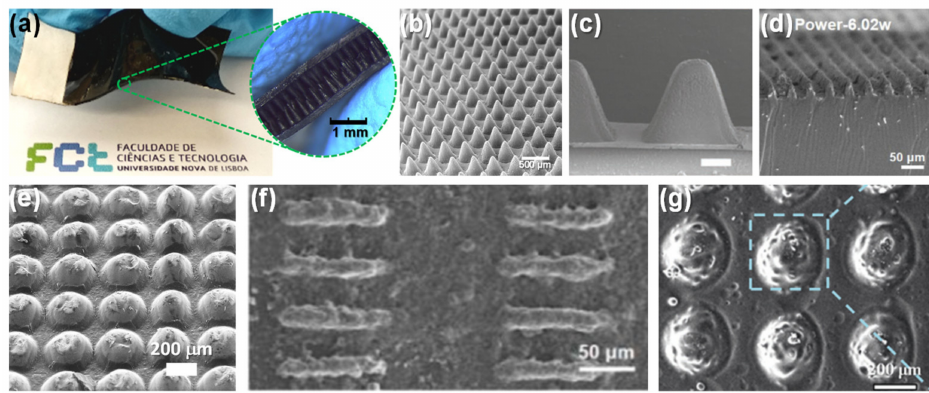
Figure 10. E-skins produced through laser engraving technique. ( a ) E-skin developed by Rui Igreja and co-workers in 2018 [22] (Copyright © 2020 WILEY-VCH Verlag GmbH & Co. KGaA, Weinheim, Germany). ( b ) SEM image of micro-cones of the e-skin in (a) [22] (Copyright © 2020 WILEY-VCH Verlag GmbH & Co. KGaA, Weinheim, Germany). ( c ) SEM image of triangular microprisms produced by Zhong Lin Wang and co-workers in 2018 (scale bar = 0.5 mm) [40] (Copyright © 2020 WILEY-VCH Verlag GmbH & Co. KGaA, Weinheim, Germany). ( d ) SEM image of triangular lines produced by Fuzhen Xuan and co-workers in 2018 [37] ( © 2020 Elsevier B.V. All rights reserved). ( e ) SEM image of semi-spheres produced by Rui Igreja and co-workers in 2019 [247]. ( f ) SEM image of short micro-ridges produced by Fuzhen Xuan in 2019 [250] (Copyright © 2020, IOP Publishing). ( g ) SEM image of hemispherical microstructures produced by Tong Zhang in 2020 (used with permission of Royal Society of Chemistry, from [253]; permission conveyed through Copyright Clearance Center, Inc.).